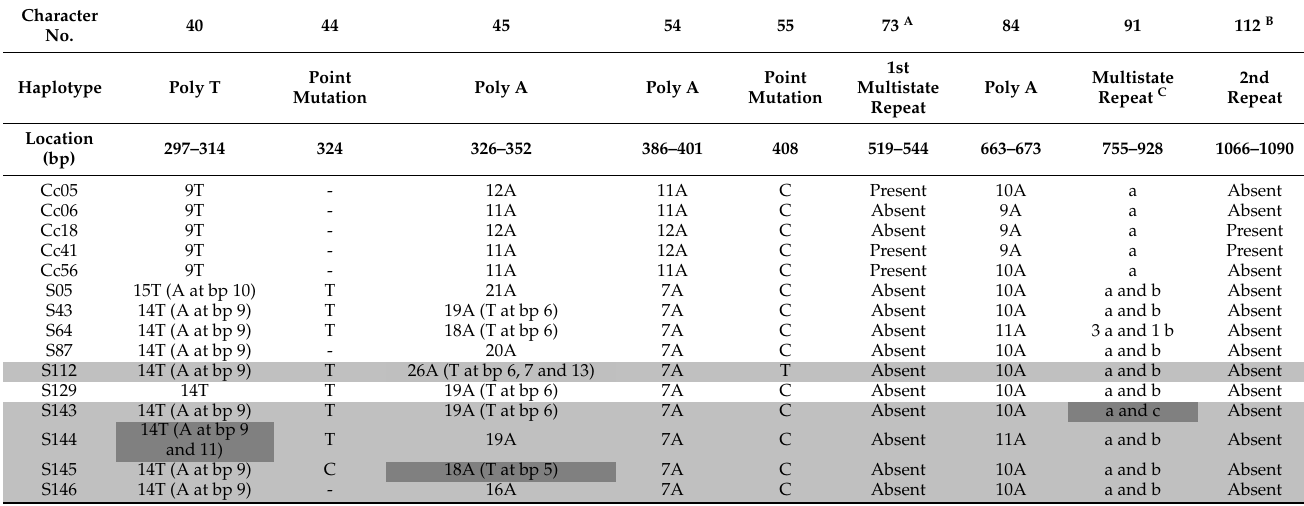
Table A1. J LA+ character variation in cpDNA haplotypes found in California 1 . Light shading indicates haplotypes not found in the native range of Eucalyptus globulus and the dark shading indicates character states not found in the native range. Character